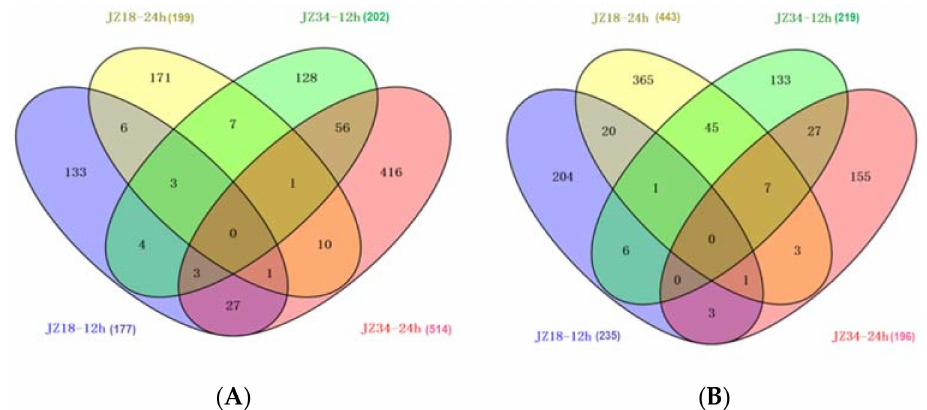
Figure 4. A Venn diagram showing overlaps among DEGs in JZ18 and JZ34 . The numbers of upregulated genes at 12 h and 24 h after K + -deficiency (0.5 mM) treatment ( A ); the numbers of downregulated genes at 12 h and 24 h after K + -deficiency (0.5 mM) treatment ( B ).